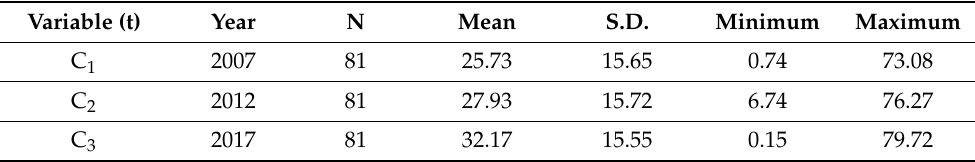
Table 3. The basic statistics of carbon storage (ton per